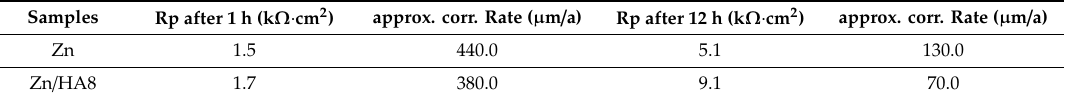
Table 4. Polarization resistance and corrosion rates in simulated body fluid (SBF).